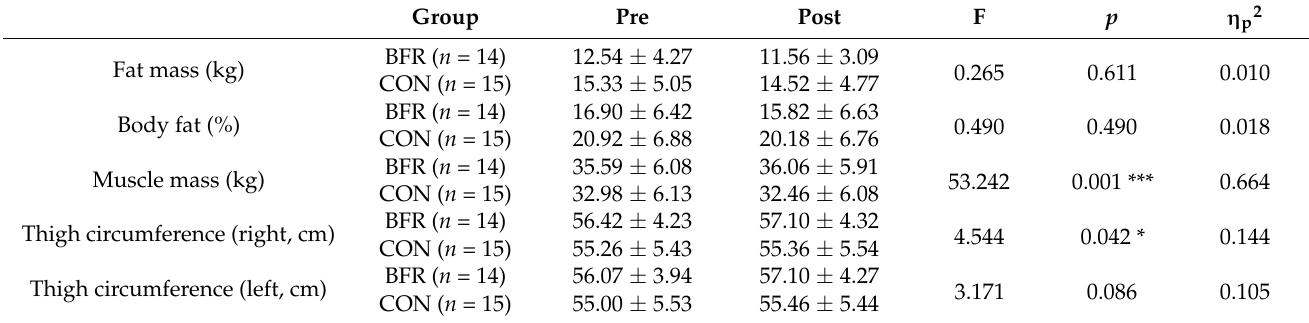
Table 2. Change in body composition after low-intensity aerobic training combined with